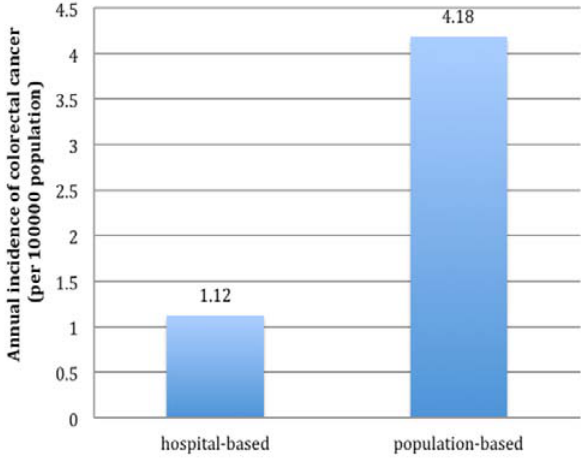
Figure 13 Comparison of incidence of colorectal cancer (per 100 000 population) in sub–Saharan Africa between hospital– based and population–based cancer